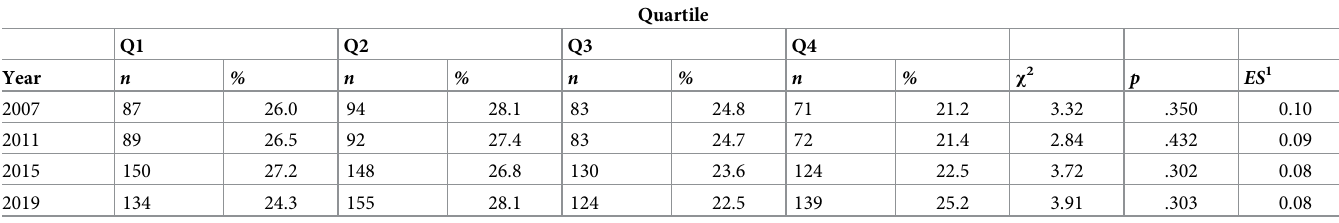
Table 7. Distribution of birth dates in female soccer players participating in the senior world cup